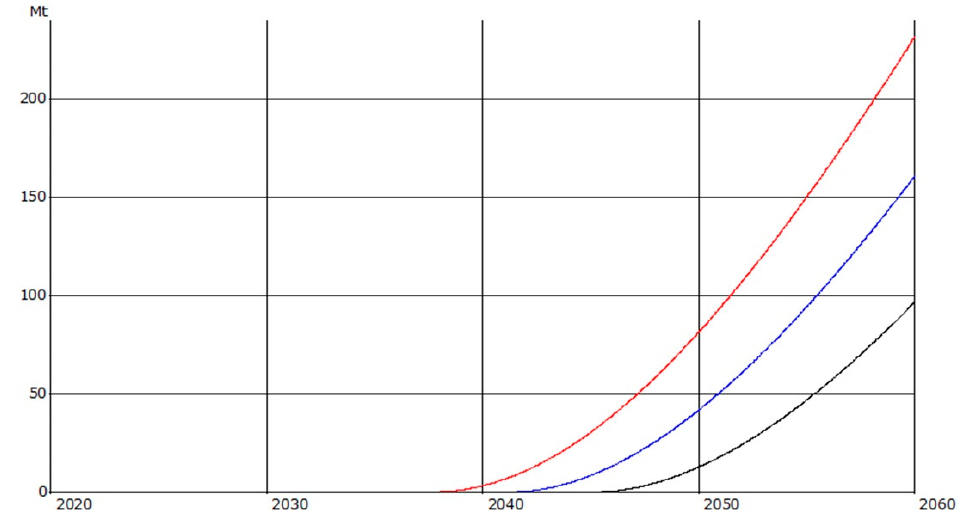
Figure 5. Evolution of the ‘unused recycled aggregates for concrete’ in the different scenarios from 2020 to 2060, measured in mega tons (Mt): Recycling (RC) scenario (red), Secondary Input (SI) scenario (blue), Resource Saving (RS) scenario (black).